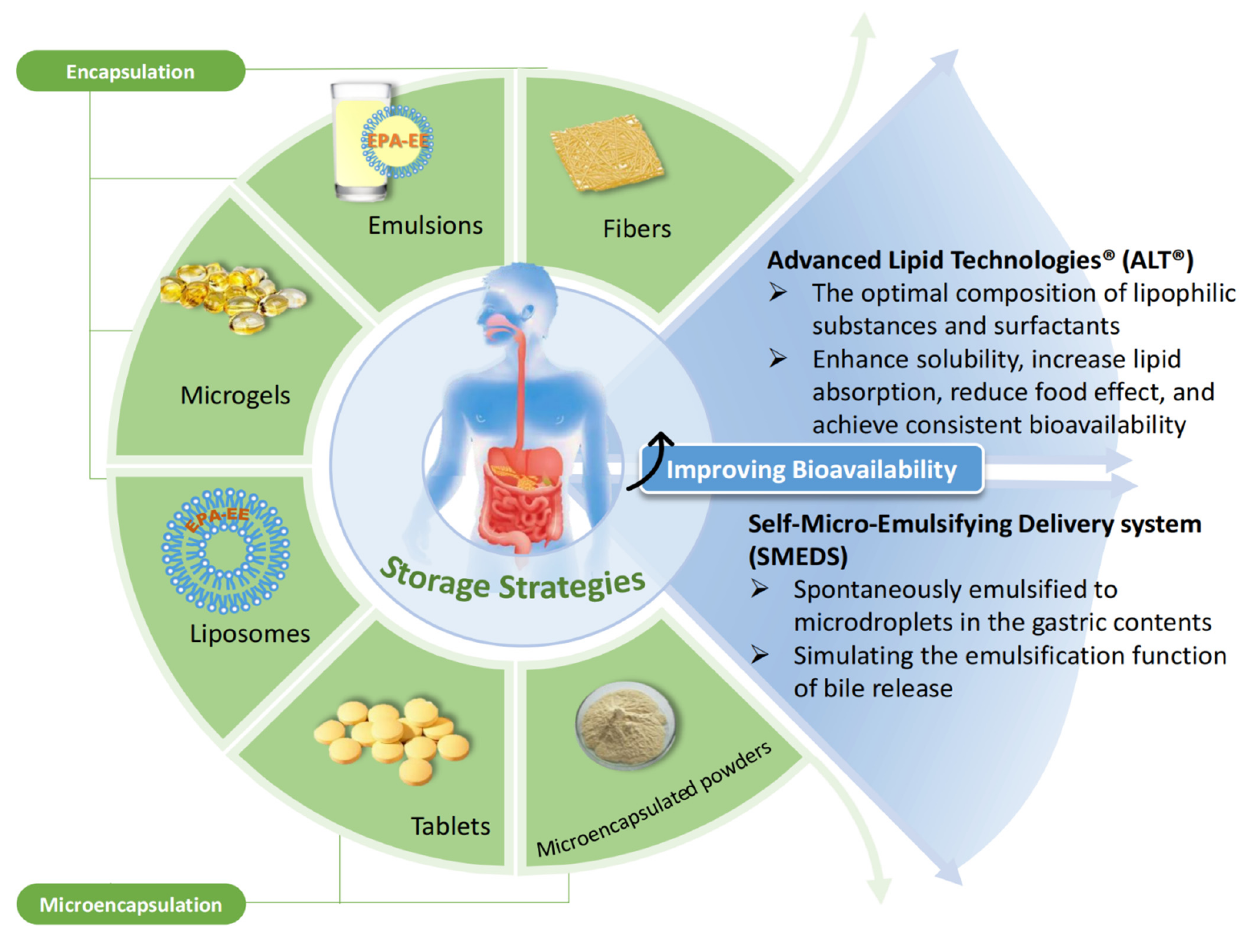
Figure 4. The most recent techniques to increase bioavailability, as well as the primary storage forms of EPA ‐ EE (or highly concentrated omega ‐ 3 PUFAs).